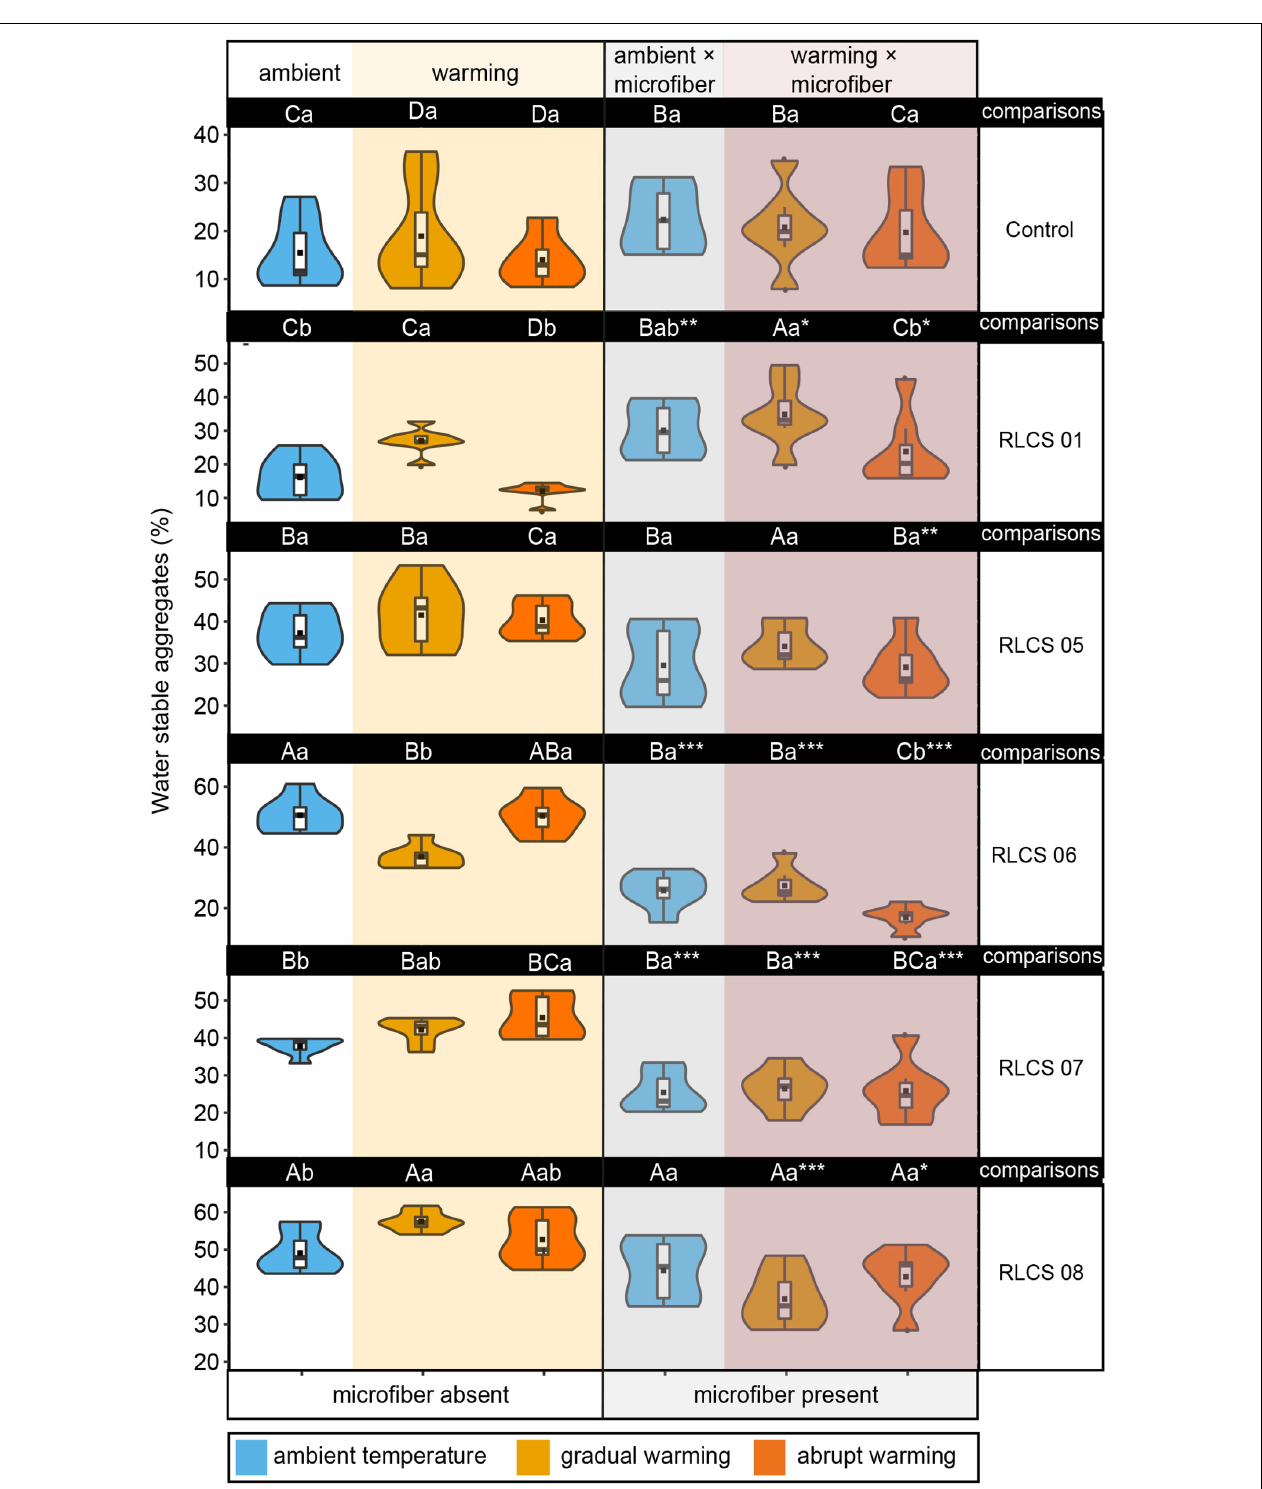
FIGURE 1 | The effects of temperature and microplastic fiber addition on the percentage of water stable aggregates depicted as violin/box plots. Different capital letters indicate significant differences (Duncan’s test, p < 0.05) among different fungi for the same treatment (i.e., in columns), and lowercase letters indicate significant differences (Duncan’s test, p < 0.05) among temperature treatments in terms of microplastic being present or absent (that is, referring to each part of a row). Significant differences ( t -test, ∗ p < 0.05, ∗∗ p < 0.01, and ∗∗∗ p < 0.001, respectively) between microplastic being present and absent within the same temperature treatment. The dots ( • ) represent outliers, squares ( (cid:4) ) represent means.